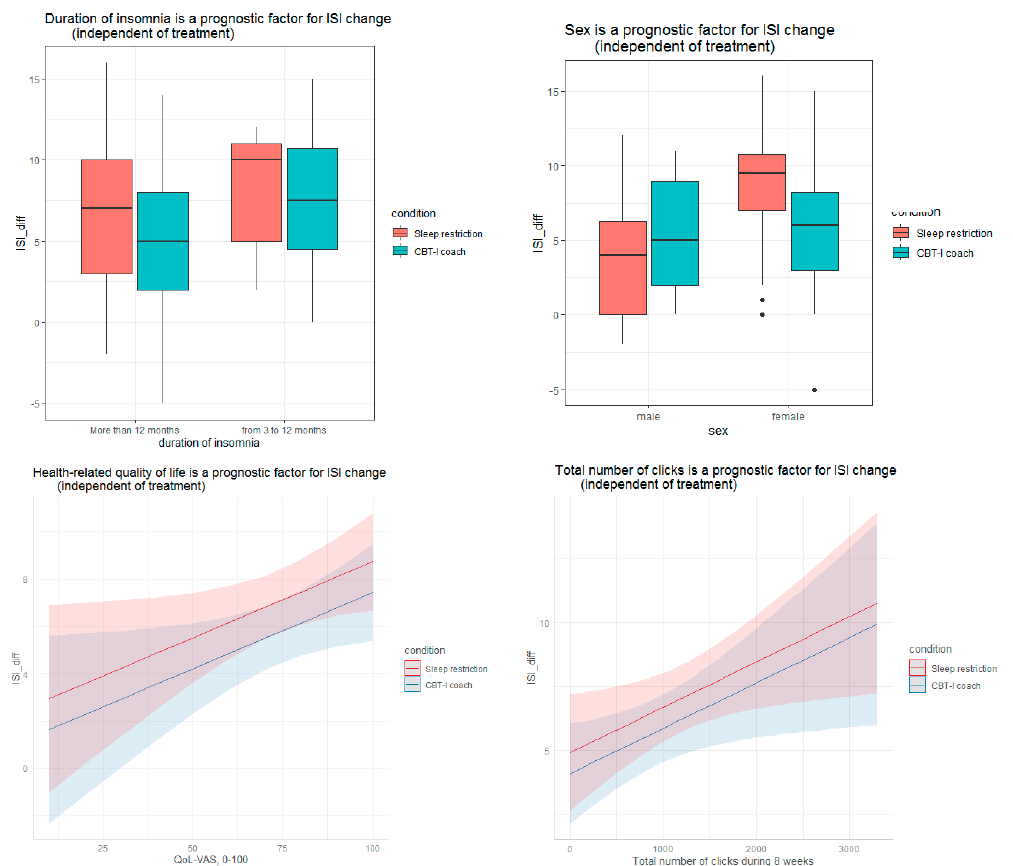
Figure 1. Prognostic value of duration of insomnia, sex, health-related quality of life, total number of clicks for ISI change after treatment course. ISI—insomnia severity index, CBT-I coach—internet- delivered multicomponent cognitive behavioral therapy for insomnia, ISI_diff—the difference of the ISI from pre-to post-treatment (ISI pre-treatment − ISI post-treatment), QoL VAS—health-related quality of life measured with visual analog scale from 0 to 100.